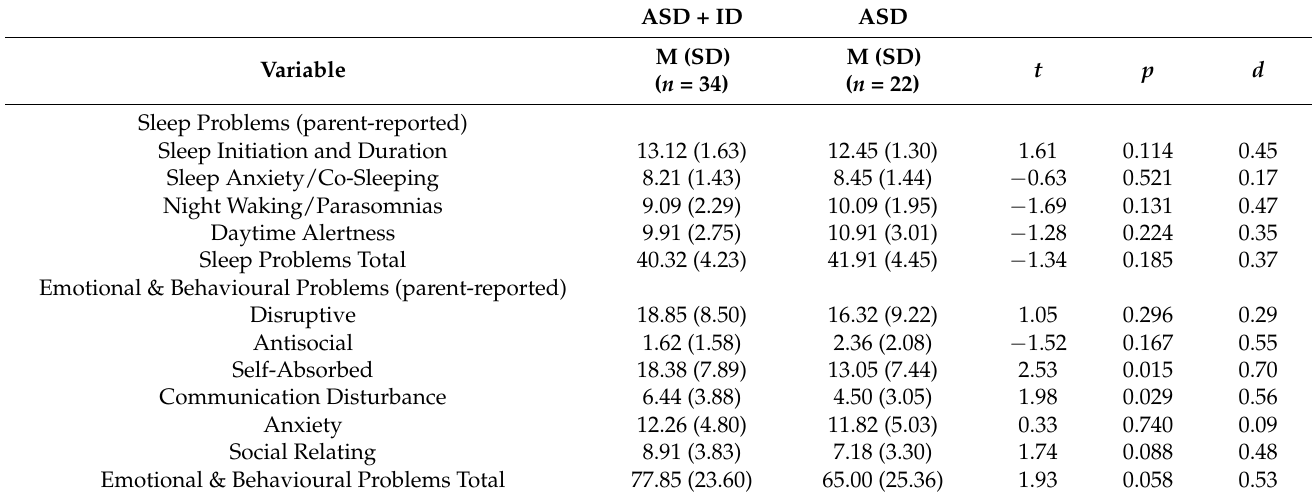
Table 2. Group Comparisons of Child Sleep Problems and Emotional and Behavioural Problems.